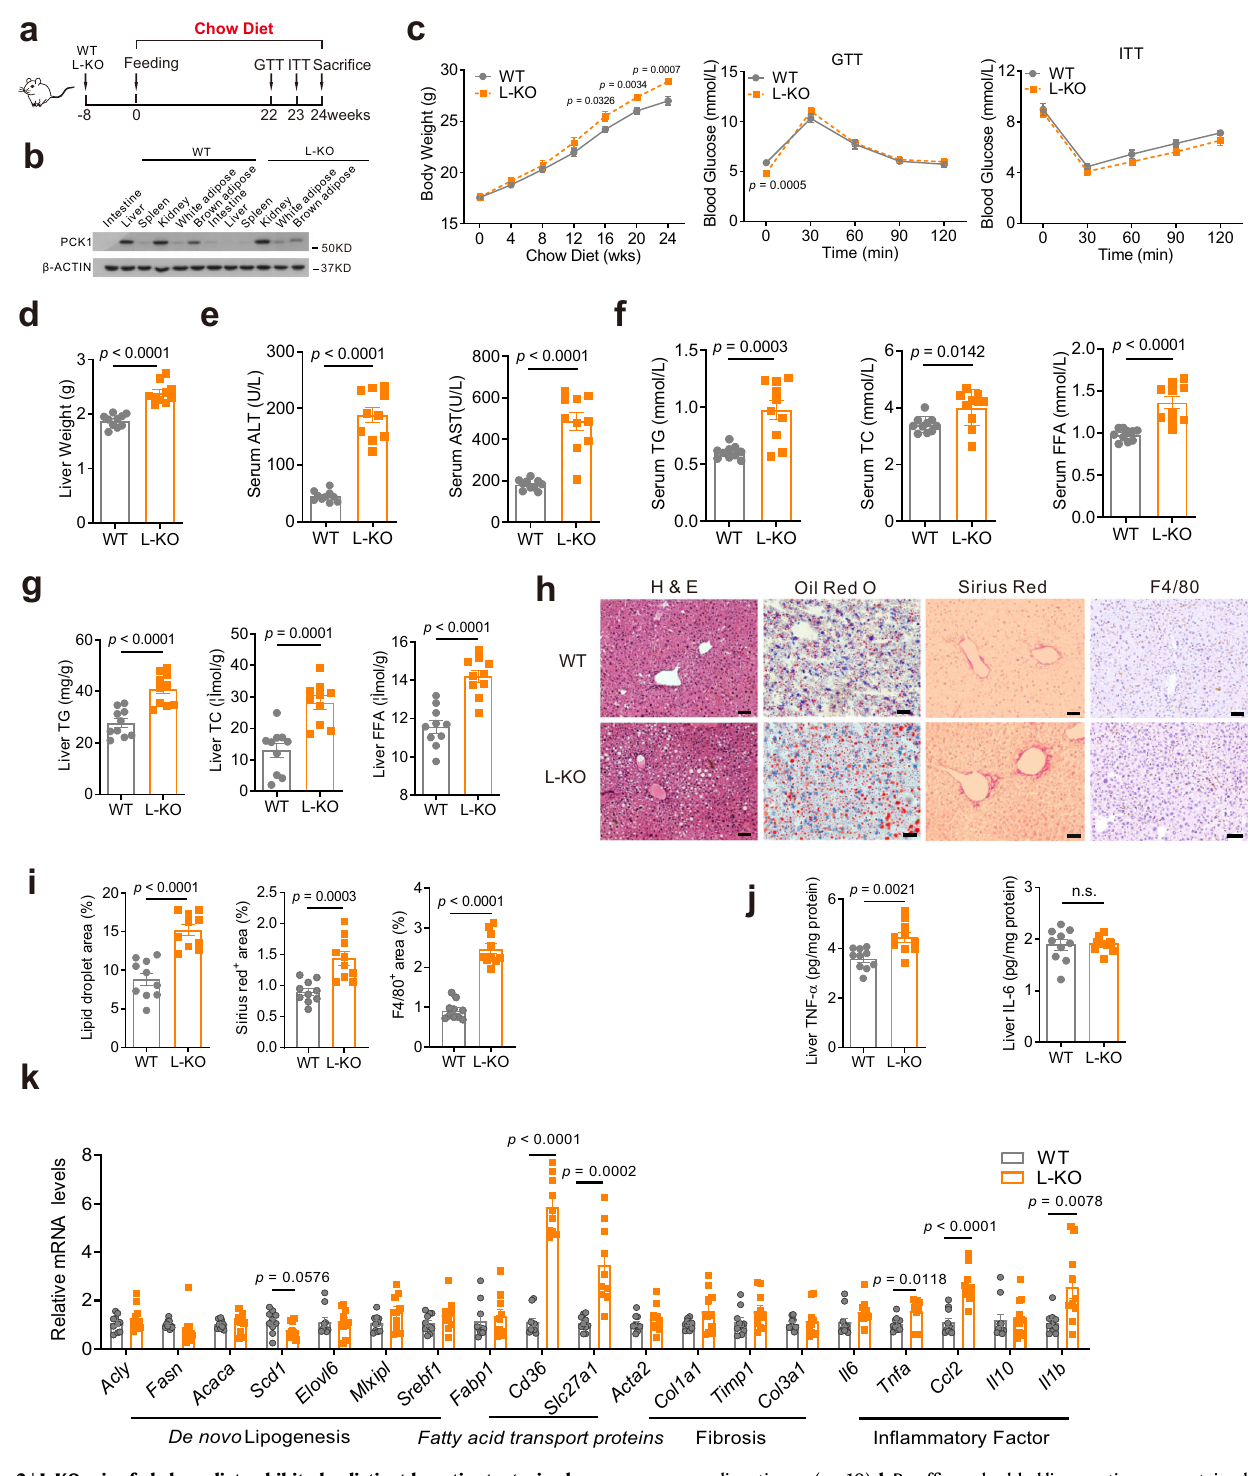
serumorlivertissues( n =10). h Paraf fi n-embeddedliversectionswerestainedwith hematoxylin and eosin (H&E), Sirius red, and F4/80. Frozen sections stained with OilRed O. Scale bars:50 µ m. i Quanti fi cationof liver sections of WT and L-KO mice fed the chow diet ( n =10). j Levels of TNF- α and IL-6 in the liver tissues ( n =10). k QuantitativePCRanalysisoflivermRNAexpression( n =10).Forimmunoblotting, the sampleswerederivedfromthesameexperimentand the blotswere processed in parallel.n was the numberof biologicallyindependent mice. Data are expressed as the mean±SEM; n.s., not signi fi cant. p values obtained via two-tailed unpaired Student ’ s t tests. Source data are provided as a Source Data fi